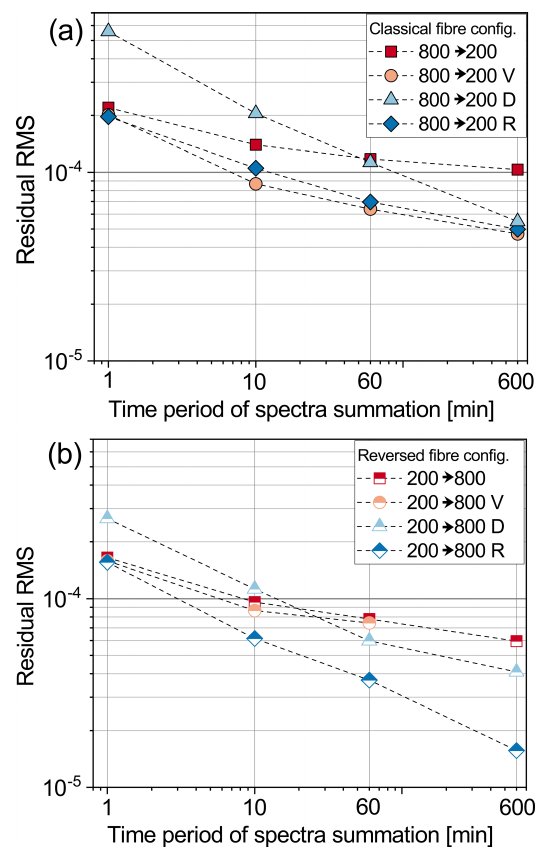
Figure 8. Residual comparison for different mode-mixing methods and its temporal stability with LDLS and the reversed fibre config- uration ( a ) and a classical fibre setup ( b ; for comparison the plot of “roughened fibre exit” for the reversed setup is also included). The mode-mixing methods are abbreviated as follows: V = vibration; D = diffuser; R = roughened fibre